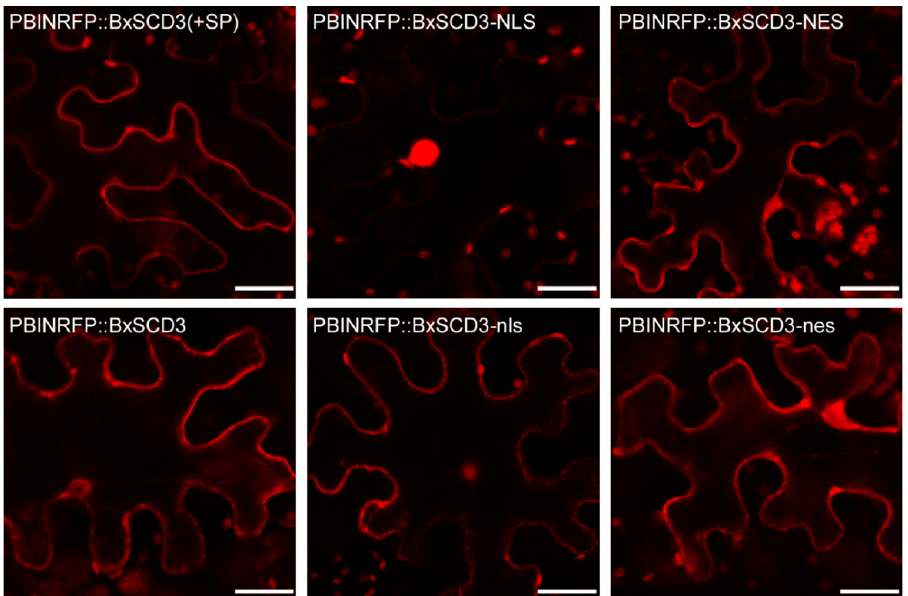
Figure 2. The subcellular localization of BxSCD3 in Nicotiana benthamiana. The subcellular localization of BxSCD3, BxSCD3 ‐ NLS (nuclear localization signal), BxSCD3 ‐ NES (nuclear export signal), and two mutant forms, BxSCD3 ‐ nls and BxSCD3 ‐ nes, were determined by transient expression of red fluorescent protein (RFP) ‐ tagged proteins in N. benthamiana leaves. Confocal microscopy images were taken 36 h post ‐ infiltration. Bars = 20 μ m.